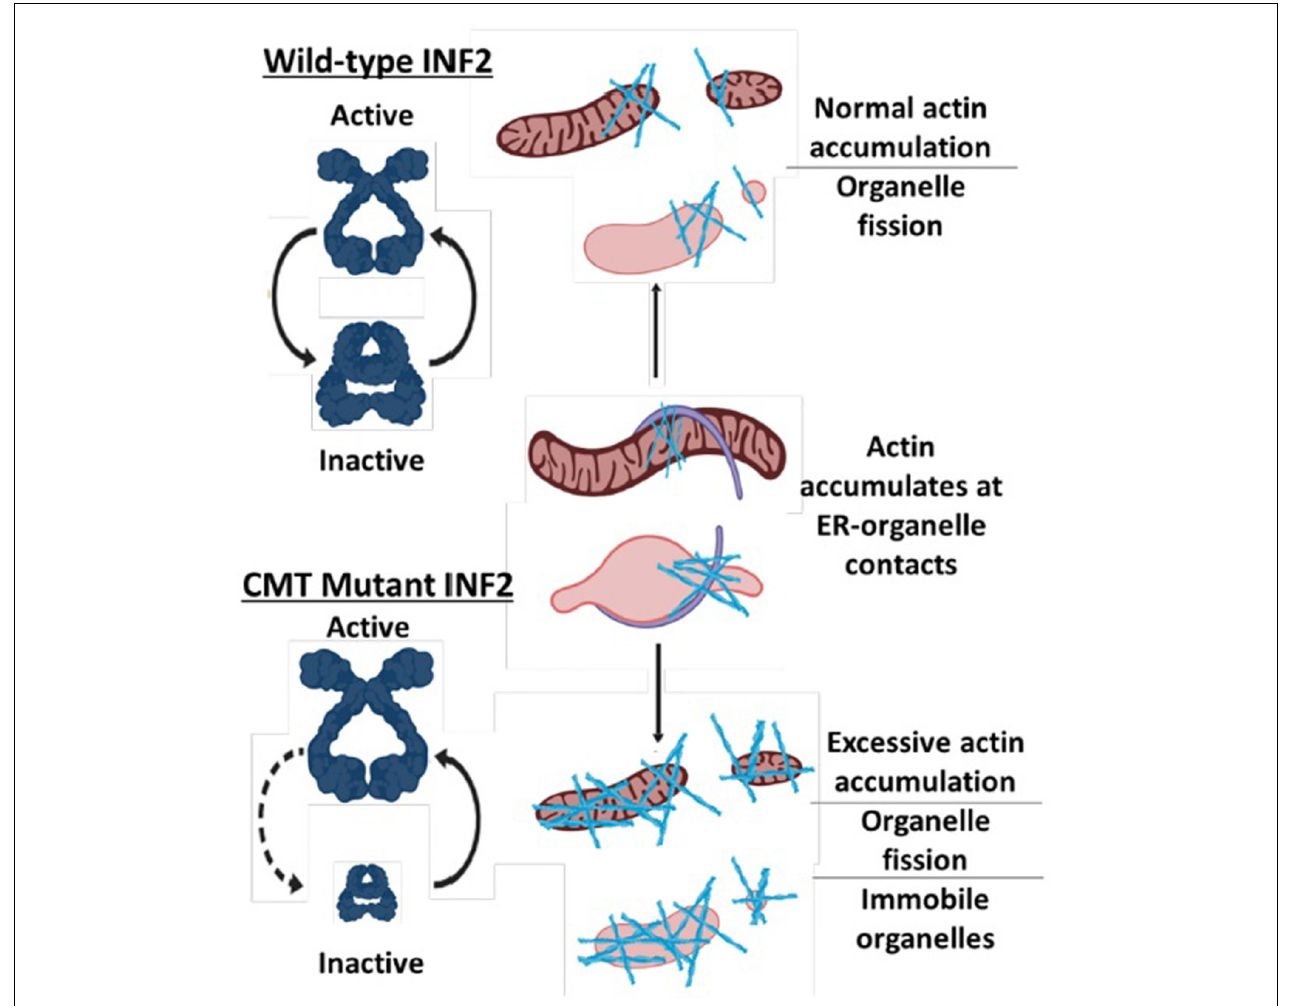
FIGURE 1 | Model for how CMT mutations in INF2 reduce mitochondrial mobility. Normal INF2 is autoinhibited as indicated by open conformation compared to the closed conformation and thus has regulated actin-assembly activity. CMT mutations in INF2 reduce autoinhibition, resulting in excessive actin assembly